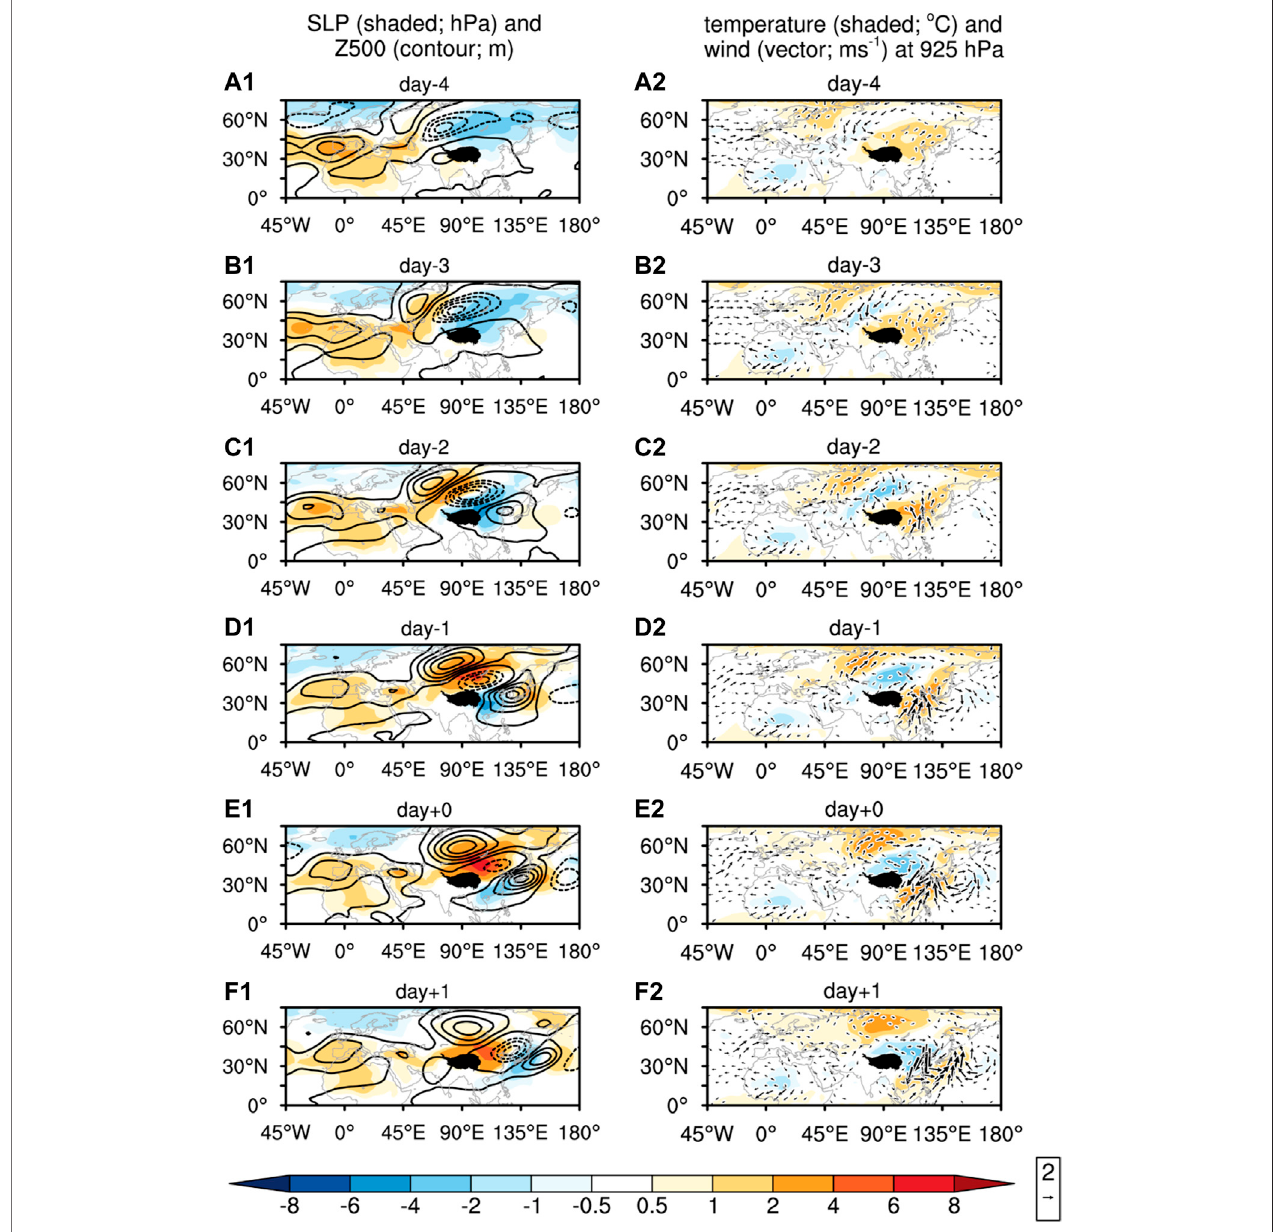
FIGURE 3 | Climatology of (A1 – F1) the sea level pressure anomalies (shaded; hPa) and the 500-hPa geopotential height anomalies (contour interval: 10 m), and (A2 – F2) theairtemperature (shaded; ° C)andwind(vector;ms − 1 )atthe925 hPafromday-4andday+1ofacoldsurge.StipplingdenotestheTibetanPlateau.Notethat the zero contour lines are omitted and positive/negative values are denoted by solid/dashed